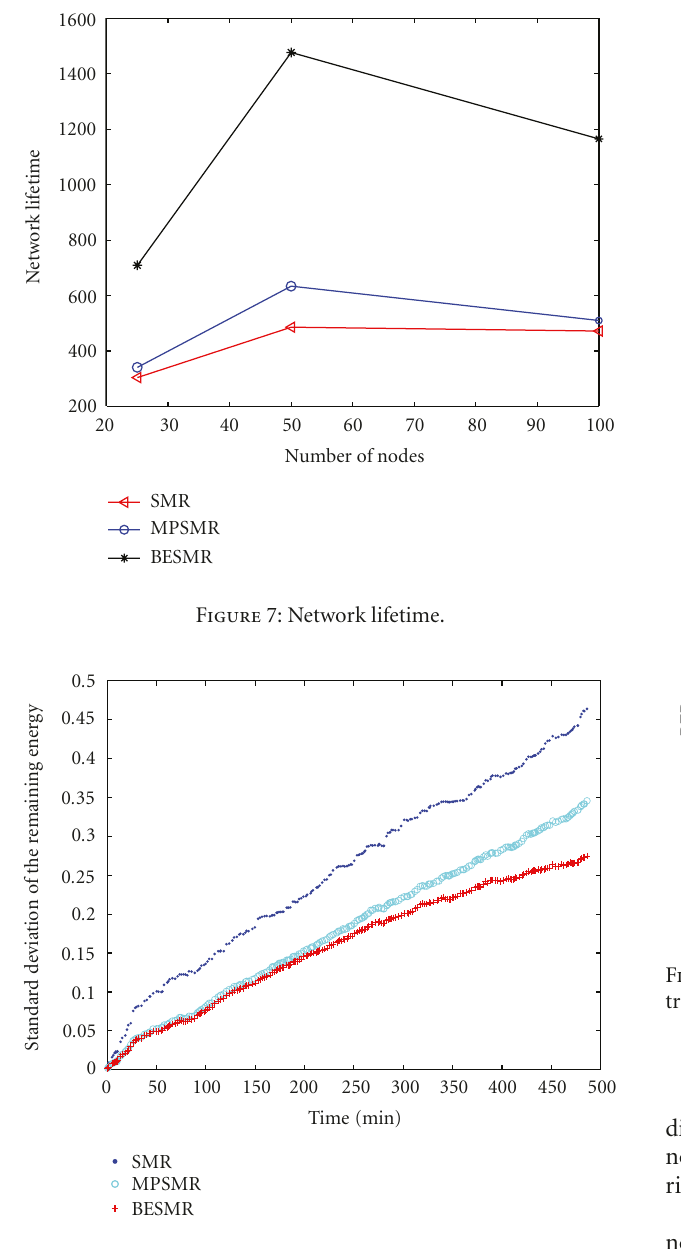
Figure 8: Standard deviation of the remaining energy at each node (50 nodes).